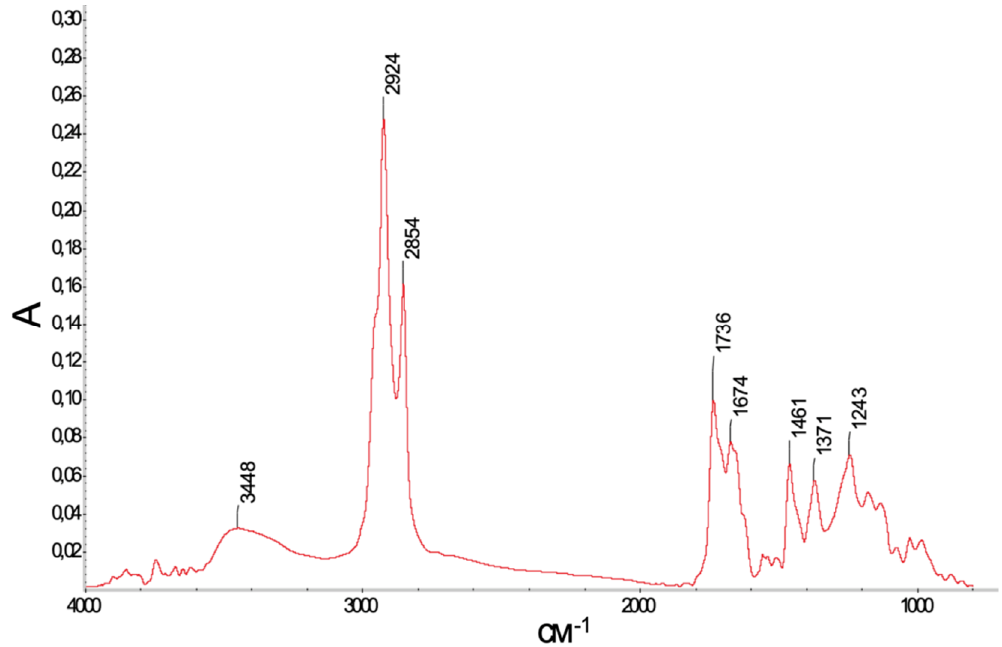
Figure 4. A transmission FTIR spectrum of metabolite I. IR (ν max , cm −1 ; band shape and vibration type assignments are given in parentheses): 3448 (broad; ν OH); 3000 (shoulder, weak; ν =C–H); 2955 (shoulder, strong), 2924, 2854 (ν as CH 3 , ν as CH 2 , ν s CH 3 , ν s CH 2 ); 1736 (asymmetric, broad; ν C=O), 1674 (asymmetric, broad; ν C=C), 1461 (asymmetric; δ as CH 3 , scis- soring δ CH 2 ), 1371 (δ s CH 3 ), 1243 (broad; ν C–CH 3 ,